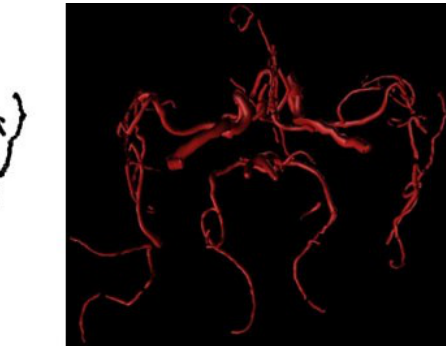
Figure 10. Reconstruction of segmentation result. From left to right: Model of Cerebrovascular segmentation; The corresponding radius of cerebral vessels; The cerebral vessels model represented by ball